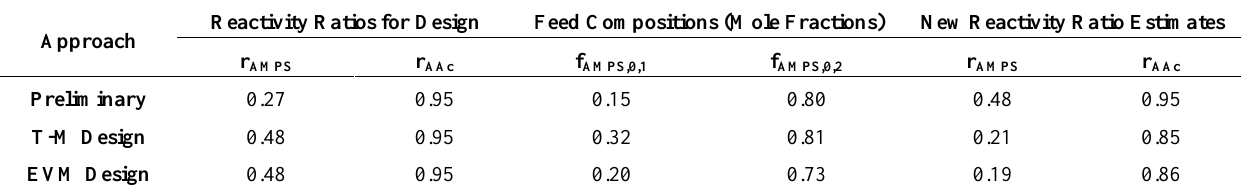
Table 4. Design of experiments and reactivity ratio estimates for